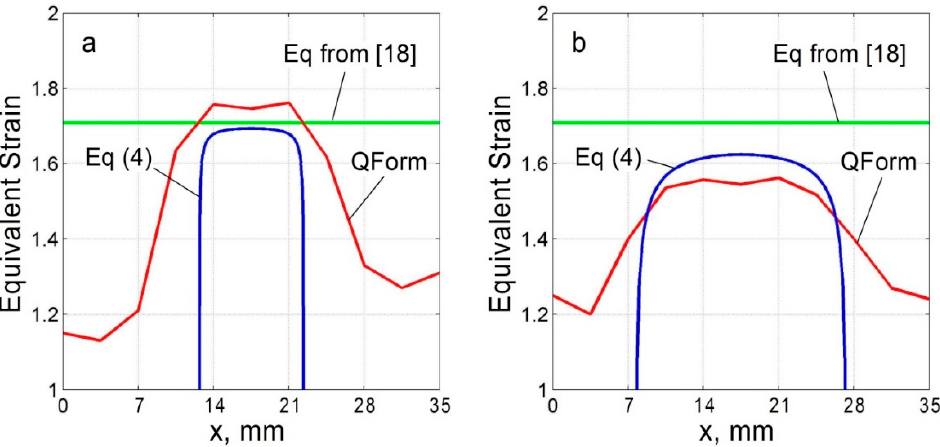
Figure 5. Dependence of the equivalent strain on the distance x from the sample end surface at r = 0.5 R : ( a ) variant 1 and ( b ) variant 2. The calculations done by using Equation (4) from the present work and the finite element simulations with QForm are seen to compare reasonably well. A constant level of equivalent strain calculated in [18] is also shown as a reference.